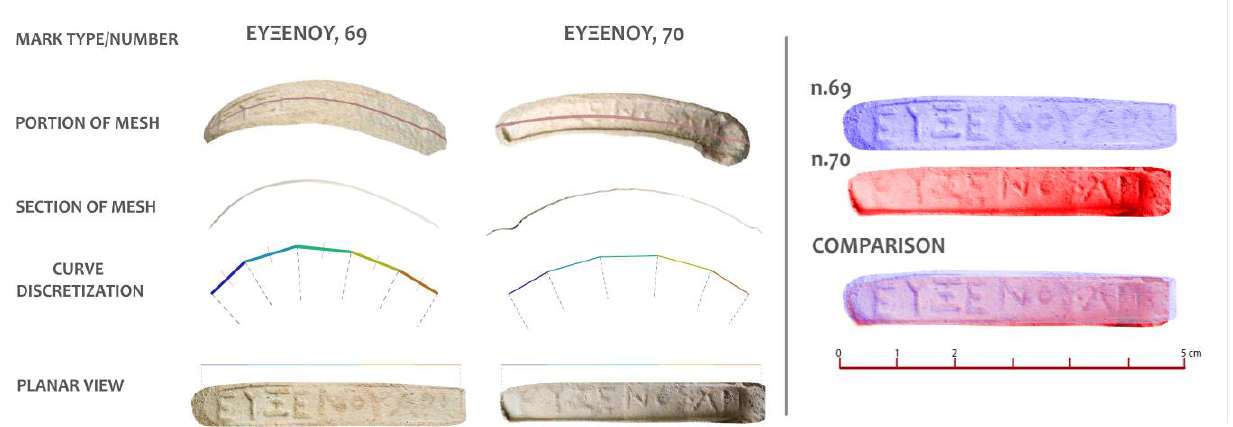
Figure 8 : Discretization of marks EYΞENOY No. 69 and No. 70. The overlap of the final images shows a correspondence of the